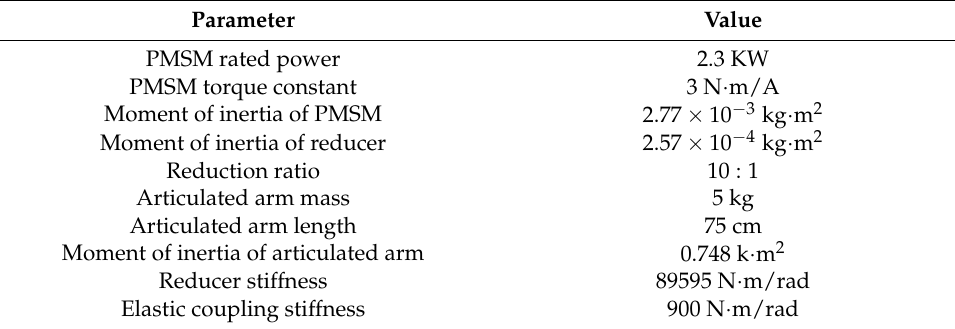
Figure 6. Single degree of freedom articulated arm test bench. Table 2. Parameters of the experimental system.